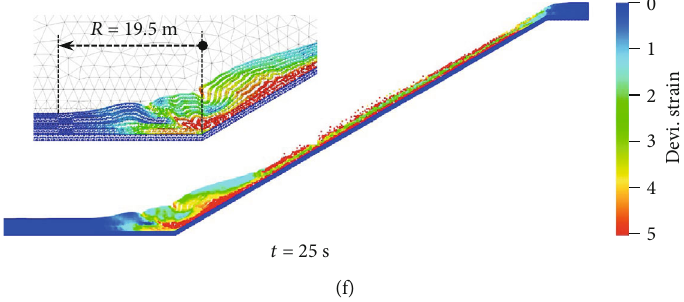
Figure 14: E ff ect of soil modulus on the post-failure behavior of a slope: (a – c) E = 5 MPa and (d – f) E = 20 MPa